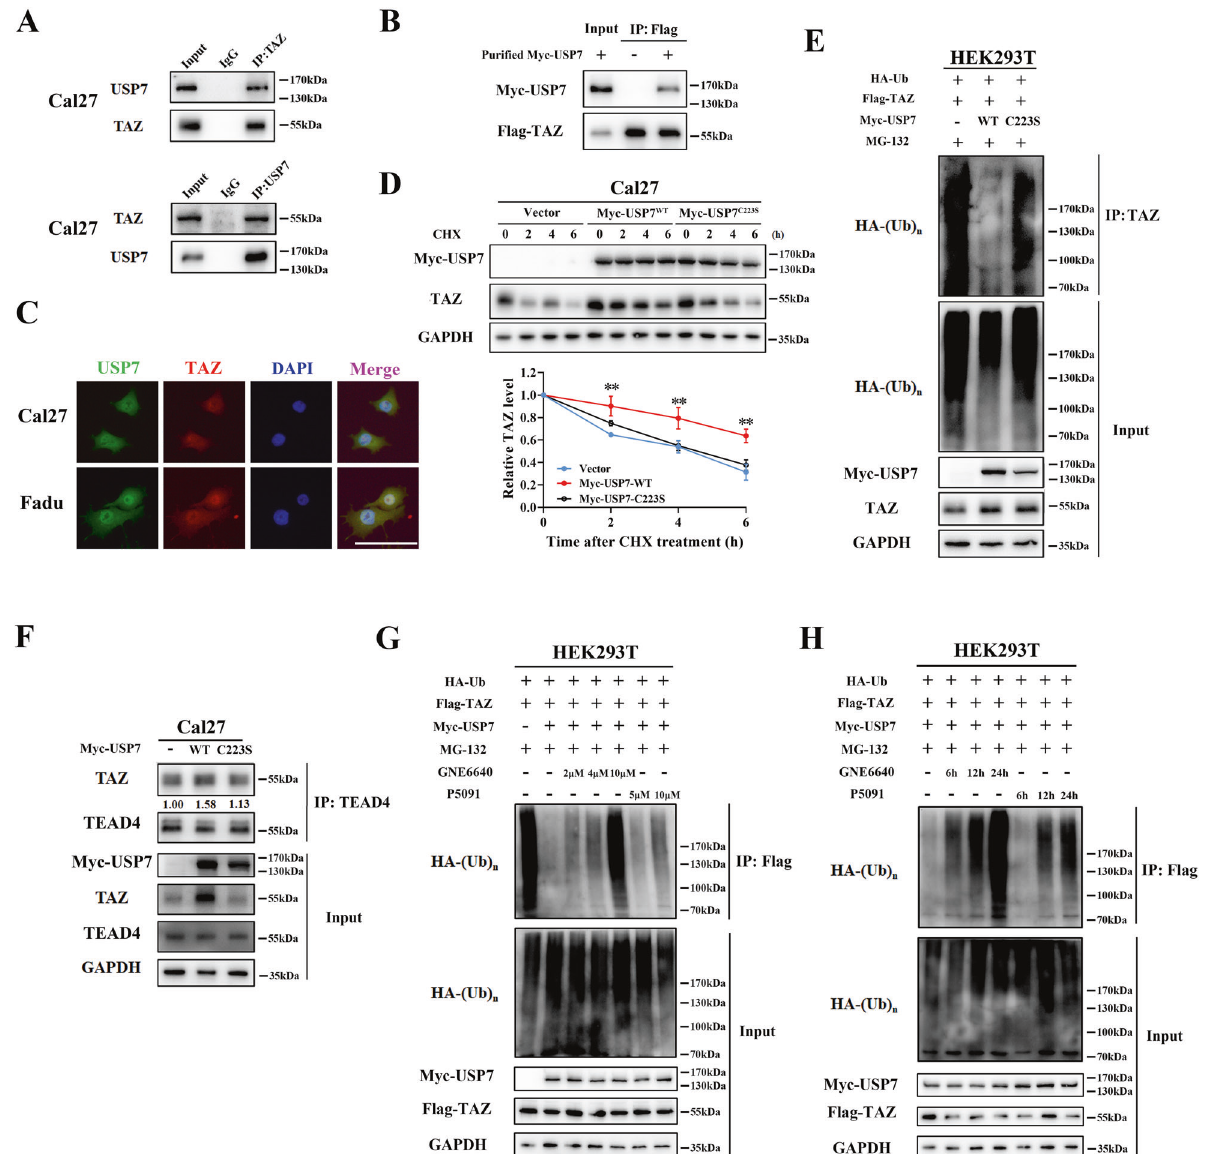
Fig. 3 USP7 is a bona fi de deubiquitinase for TAZ. A USP7 protein associated with TAZ protein. Cal27 cell lysates were subjected to immunoprecipitation with anti-TAZ (upper panel) or anti-USP7 (lower panel) antibody followed by immunoblot with anti-TAZ/anti-USP7 antibody. B Puri fi ed Flag-TAZ and Myc-USP7 proteins were mixed with equimolar and then subjected to IP assay by anti-Flag magnetic agarose. The binding of Myc-USP7 and Flag-TAZ in vitro were detected by western blot. C Cellular immuno fl uorescence assay shown USP7 (FITC, green) predominantly co-localized with TAZ (Cy3, red) in nucleus in Cal27 and Fadu cells. Scale bar: 50 μ m. D Myc-tagged USP7 wide- type (USP7 WT ) and its mutant (USP7 C223S ) plasmids were transfected into HEK293T cells which were then subjected to CHX chase assay at the indicated time points. E HEK293T cells were co-transfected with HA-Ub with/without Myc-USP7 WT or Myc-USP7 C223S and treated with MG-132 for 8 h before collection. Exogenous TAZ ubiquitination was determined by immunoprecipitation by anti-TAZ antibody and immunoblotted with anti-HA antibody. F Myc-tagged USP7 wide-type (USP7 WT ) and its mutant (USP7 C223S ) plasmids were transfected into Cal27 cells for 48 h. The whole cell lysates were subjected to immunoprecipitation by anti-TEAD4 antibody and immunoblotted with anti-TAZ antibody. G TAZ ubiquitination was determined in HEK293T cells transfected with indicated plasmids. HEK293T cells were co-transfected with Flag-TAZ, HA-Ub, Myc-USP7. Cells were treated with indicated dosage of GNE6640 (2, 4, 10 μ M) or P5091 (5, 10 μ M) for 24 h. Then, cell lysates were subjected to immunoprecipitation by anti-Flag antibody and immunoblotted with anti-HA antibody. H HEK293T cells were co-transfected with Flag-TAZ, HA-Ub, Myc-USP7. Cells were treated with GNE6640 (10 μ M) or P5091 (10 μ M) and harvested at indicated time points (6, 12, 24 h). TAZ ubiquitination was detected by IP and western blot, respectively. Data were presented with representative images from three independent experiments. * p < 0.05, ** p < 0.01. lines (Fig. 7E and Supplementary Fig. 13B). To further unravel the Supplementary Fig. 13A) [9, 34, 45]. In addition, bioinformatics biological signi fi cance of USP7-TAZ axis in HNSCC, we extracted analyses of transcriptomic datasets from Cancer Cell Line the gene candidates positively associated with USP7 or TAZ in Encyclopedia database revealed signi fi cantly positive associations TCGA-HNSC samples (Spearman ’ s correlation >0.3) and found 440 between USP7 expression and CYR61/CCN1 ( R = 0.4498, p < 0.0111), CTGF/CCN2 ( R = 0.3141, p < 0.0426) in 31 HNSCC cell overlapped genes which were further subjected to GO and KEGG Cell Death and Disease (2022)